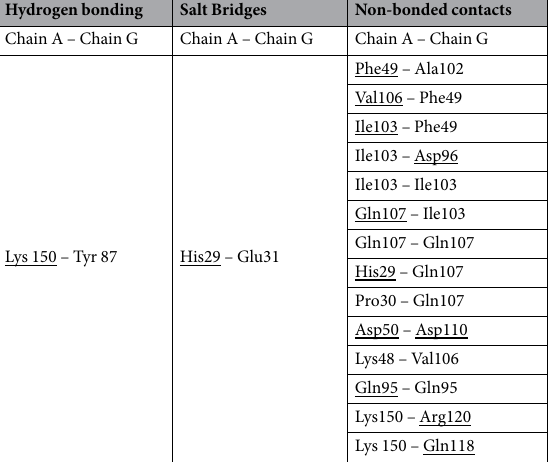
Table 3. Table of residues involved in the interactions between weakly associated dimer of fragment 28–161. The highlighted resides (underlined) are the residues that are also involved in interaction with actin. The interactions were generated using EBI PDBSUM 20 and the interactions with actin were determined from the crystal structure